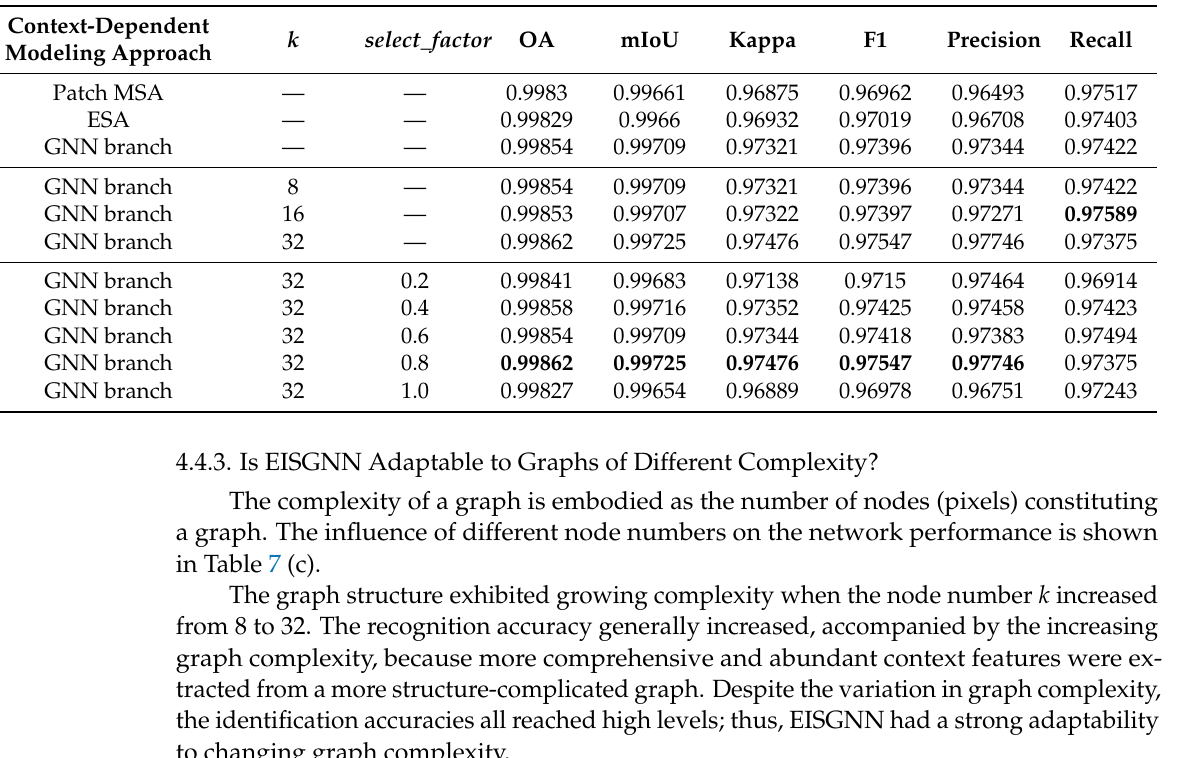
Table 7. Ablation experiments on different network hyperparameters. MSA means patch-based multi-head self-attention, and ESA indicates efficient self-attention. F1 indicates the F1-score. Bold values mean the highest number of the corresponding evaluation